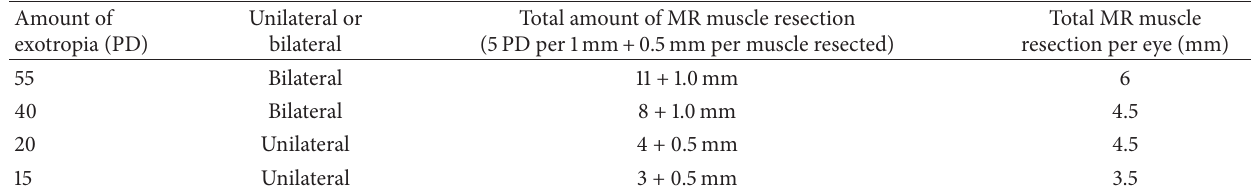
Table 3: Examples for calculating amount of MR muscle